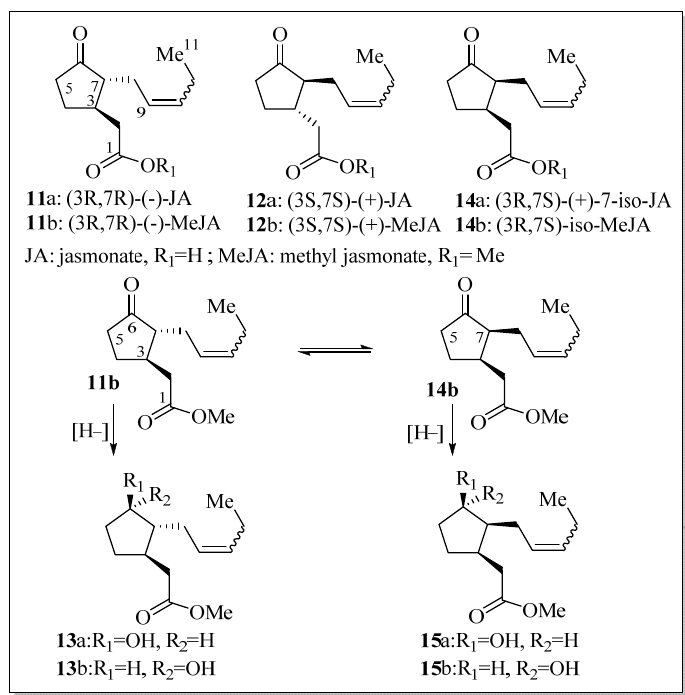
Figure 1. Naturally occurring jasmonate isomers and synthetic isomers.